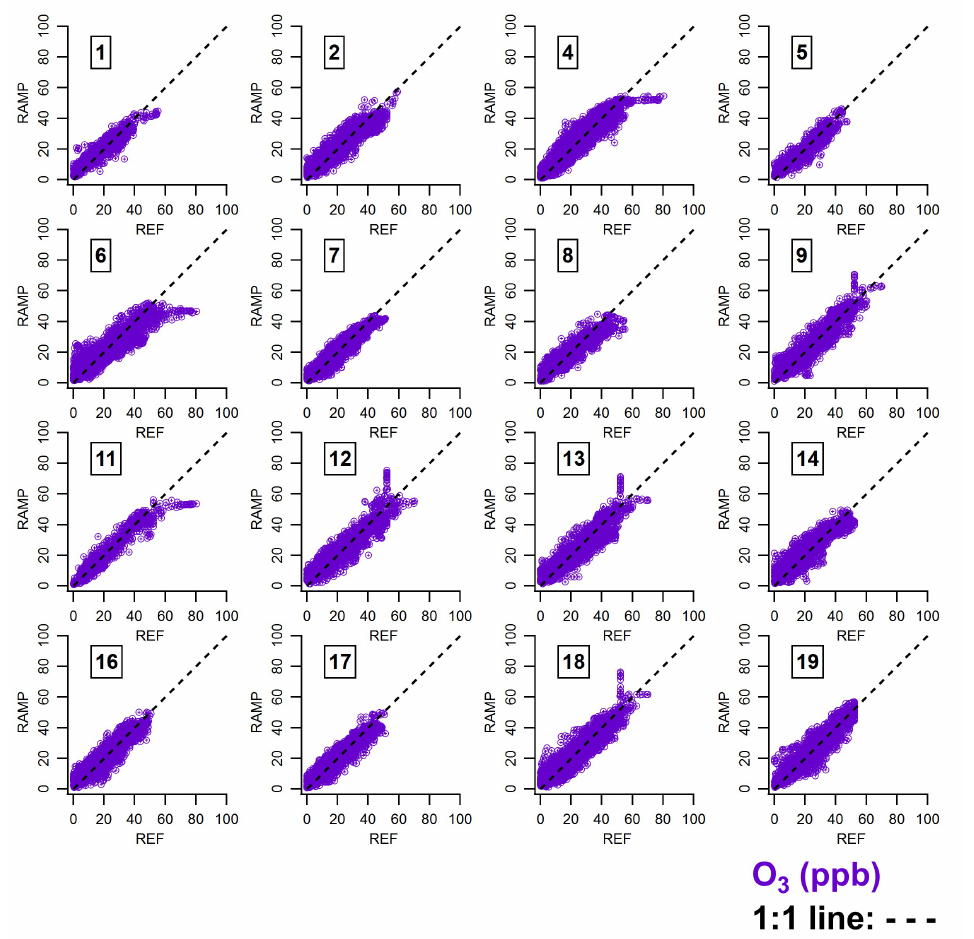
Figure 5. RF model performance for ozone evaluated using the testing data (data withheld from building model). Correlation plots show predicted ozone concentration (“RAMP”) versus the reference monitor concentration (“REF”) for 16 RAMP units. All values are in ppb, and the 1 : 1 line is drawn as a black dashed line.